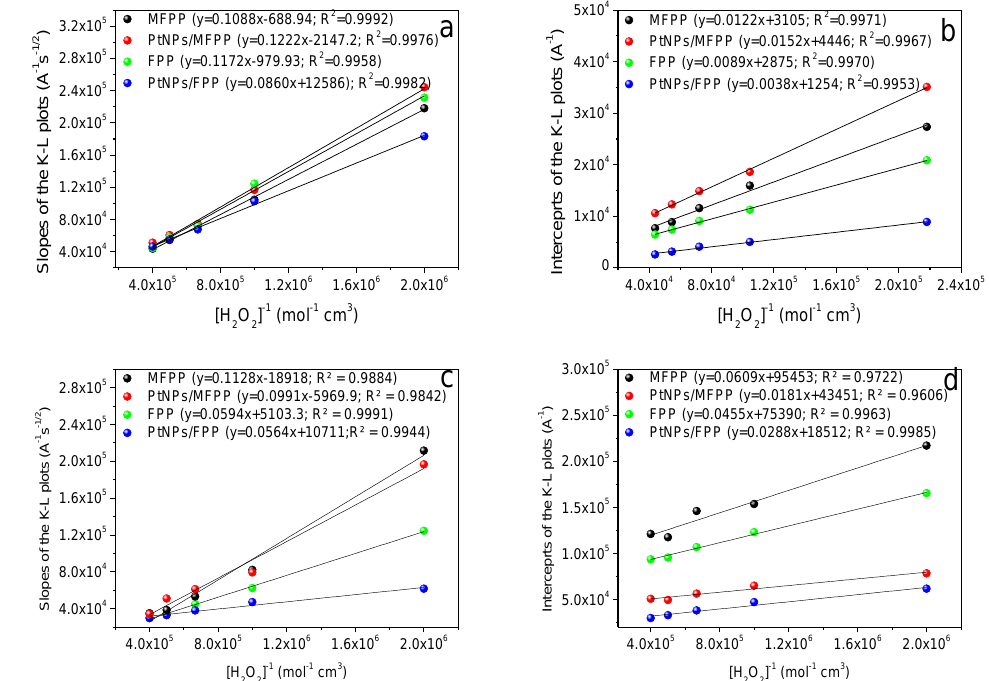
Figure 5. Slopes and intercepts of anodic ( a , b ) and cathodic ( c , d ) Koutecky–Levich plots vs. [H 2 O 2 ] −1 at the modified electrodes with average coverages of 4.22 × 10 −10 mol Fc cm −2 (MFPP), 1.89 × 10 −10 mol Fc cm −2 (PtNPs/MFPP), 4.72 × 10 −10 (FPP) and 3.33 × 10 −10 mol Fc cm −2 (PtNPs/FPP). All measurements were in 0.01 M phosphate buffer (pH 7.0) and NaClO 4 0.1 M as supporting electrolyte. The data showed are the average values of at least five electrodes. Table 2 summarizes the average results of at least five electrodes with coverages within the optimal range. Table 2. Results of the kinetic studies of hydrogen peroxide and oxygen catalysis. Electrode